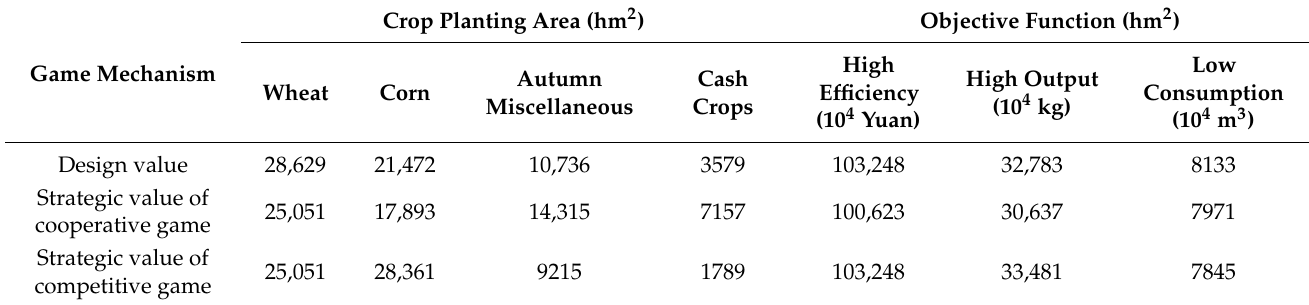
Table 3. Optimisation results of crop planting obtained using different game mechanisms.